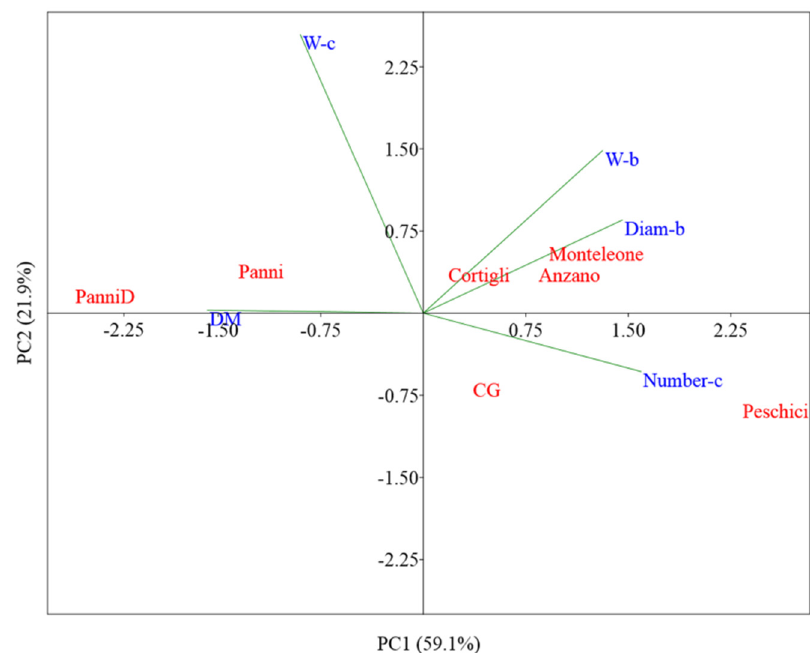
Figure 1. Principal component analysis bi-plot (PC1 vs. PC2) showing the spatial distribution of the main biometrical traits as affected by genotypes. The considered biometrical traits were: Weight of cloves (W-c), number of cloves per bulb (Number-c), weight of bulbs (W-b), diameter of bulbs (Diam-b), concentration of dry matter (DM).